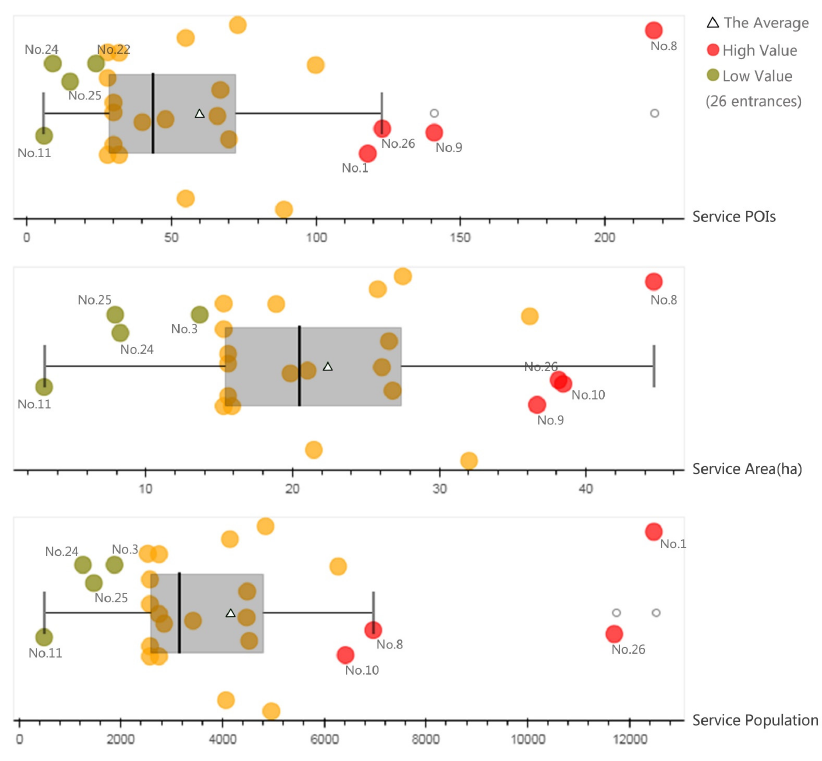
Figure 4. Service capacity of entrances.